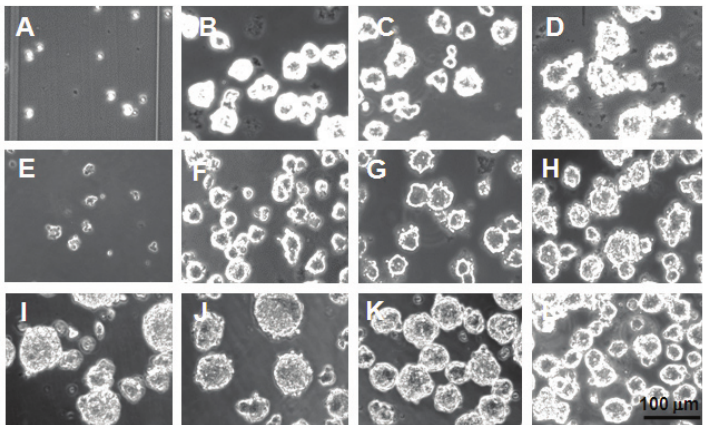
Figure 4. HNK-1 +ve ENS cells in rotating culture form aggregates. ENS cells at 0 h ( A ), 4 h ( B ), 18 ( C ) and 48 h ( D ) show rapid aggregation without the later formation of super-aggregates. The importance of cadherins is shown by Ca 2+ -chelation with 1 mM EGTA, which reduced aggregate formation at 18 h ( E ). F – H . Altering the rotation speed (0 rpm ( F ), 75 rpm ( G ) and 150 rpm ( H )) had only slight effect on aggregation at 18 h. I – L . Increasing the initial ENS cell density (0.167×10 6 cells/ml ( I ), 0.33×10 6 cells/ml ( J ), 0.67×10 6 cells/ml ( K ), 1.0×10 6 cells/ml ( L )) resulted in a decrease in the aggregate size by 18